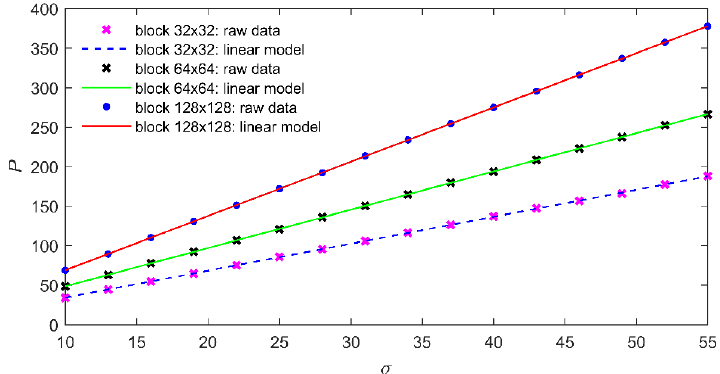
Figure 3. The average P ( M ) values across a range of noise levels and the associated results of least-square fitting.